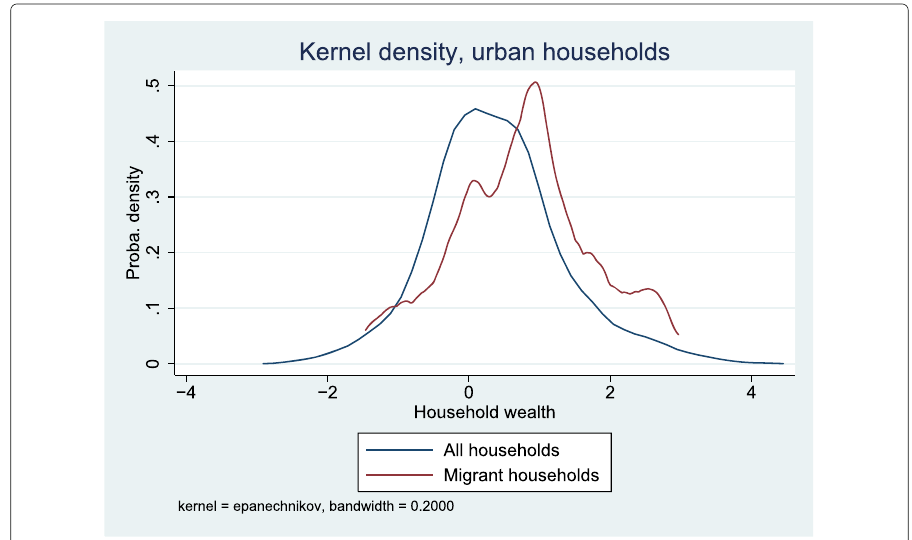
Fig. 6 Post-departure household wealth and migration: urban